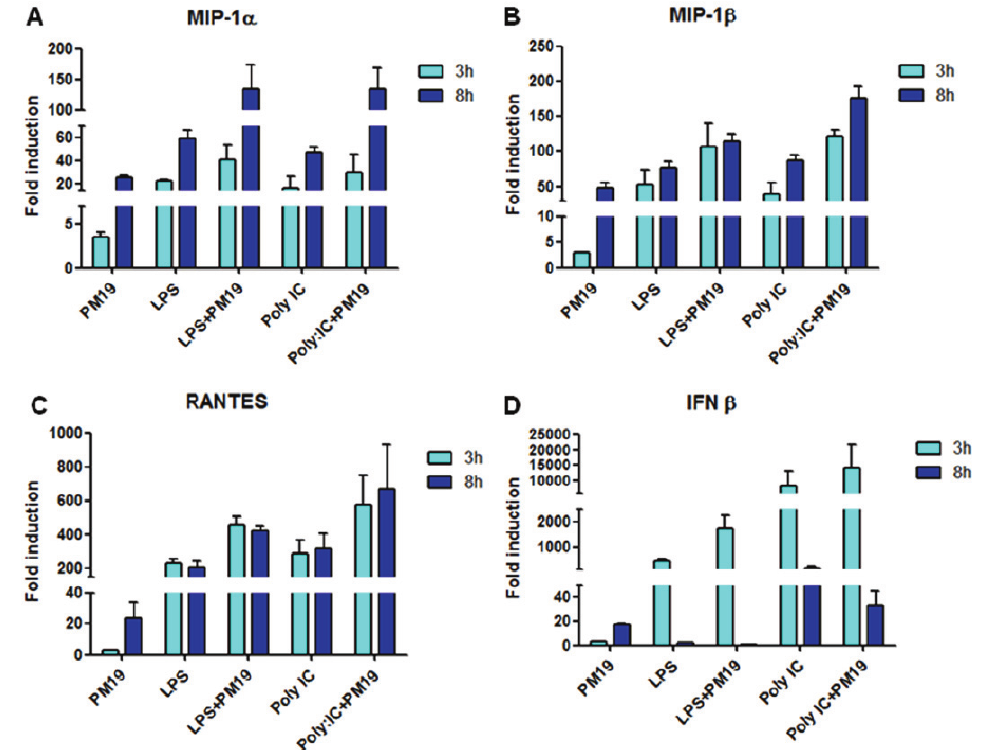
Figure 4. β chemokines ( A – C ) and IFN β ( D ) expression following PM 19 stimulation for 3 and 8 h. Data are shown as fold change expression from the unstimulated sample. Experiments were conducted on iMDDCs from 3 different healthy donors. Data represent the mean ± SD.